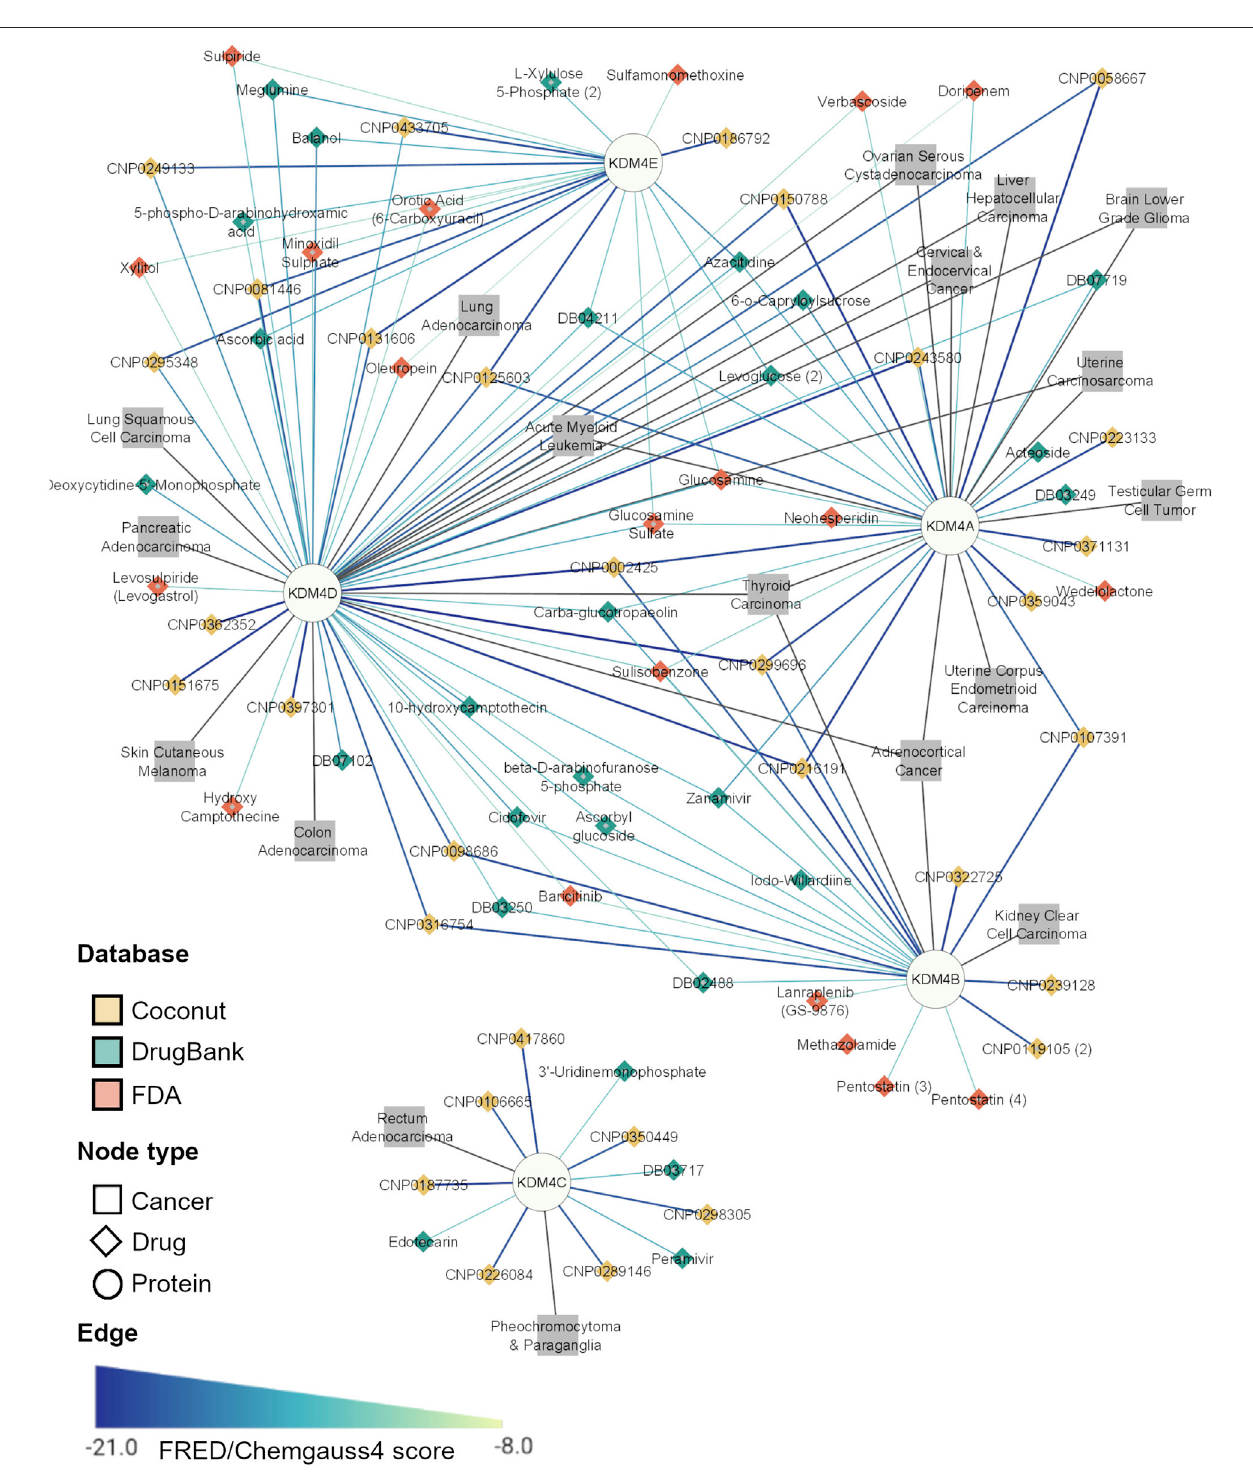
FIGURE 6 | Top potential inhibitors of the KDM4A family. The network represents the Drug-Protein and Disease-Protein relationship between the members of the KDM4 family. The Drug-Protein edge width and color intensity represents the FRED/Chemgauss4 score. For long compound names only the database ID is provided.